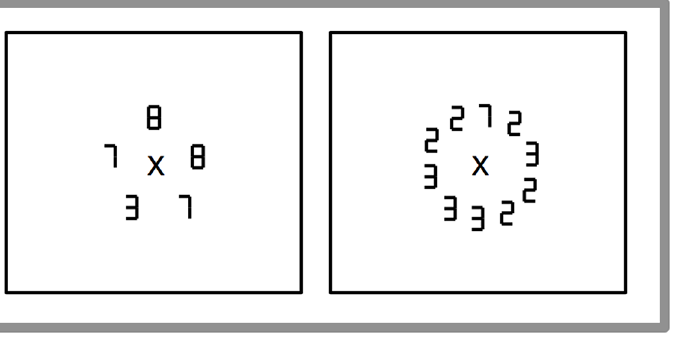
Figure 6. Example digit arrays for serial search and ensemble estimation task in Experiment 2. Note. Displays consisted of 5, 7, or 10 items with digits consisting of only 2, 3 and 7, 8. Participants were asked to estimate the average numerical value of the digits as less than or greater than five for the ensemble task, and to report the location (left or right side of the screen) of the less-than-five or greater-than-five digit for the search